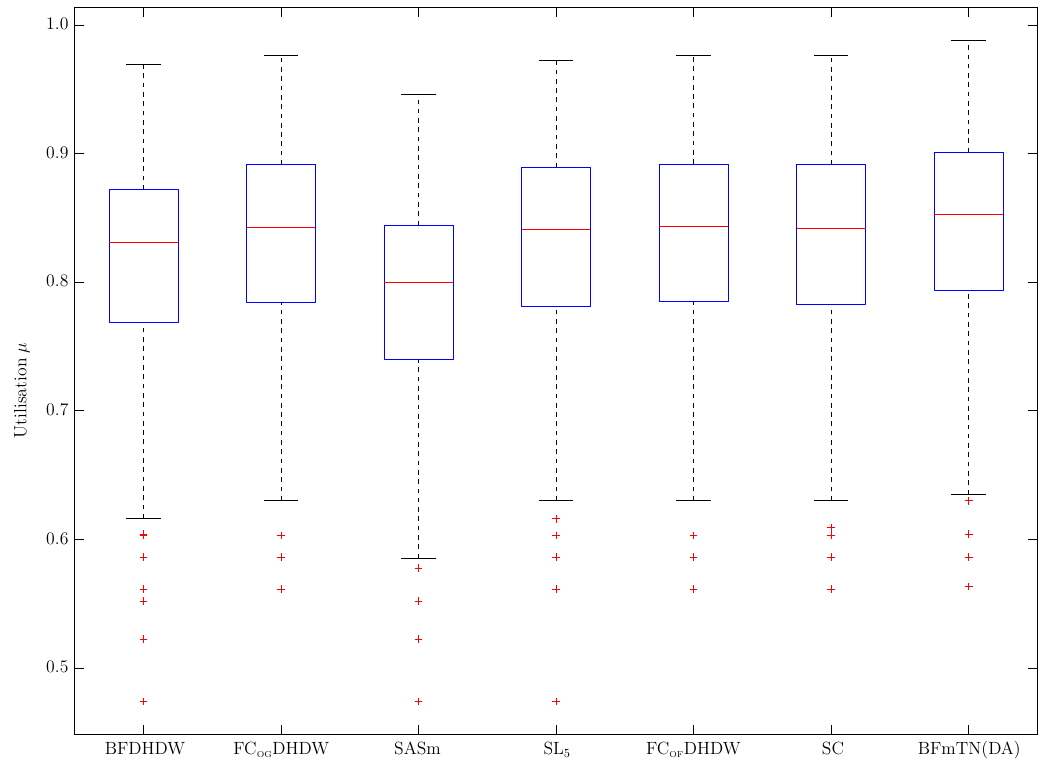
Figure 6: Box plot of the utilisations achieved by the best heuristics for the VSBPP when applied to the 857 VSBPP benchmark